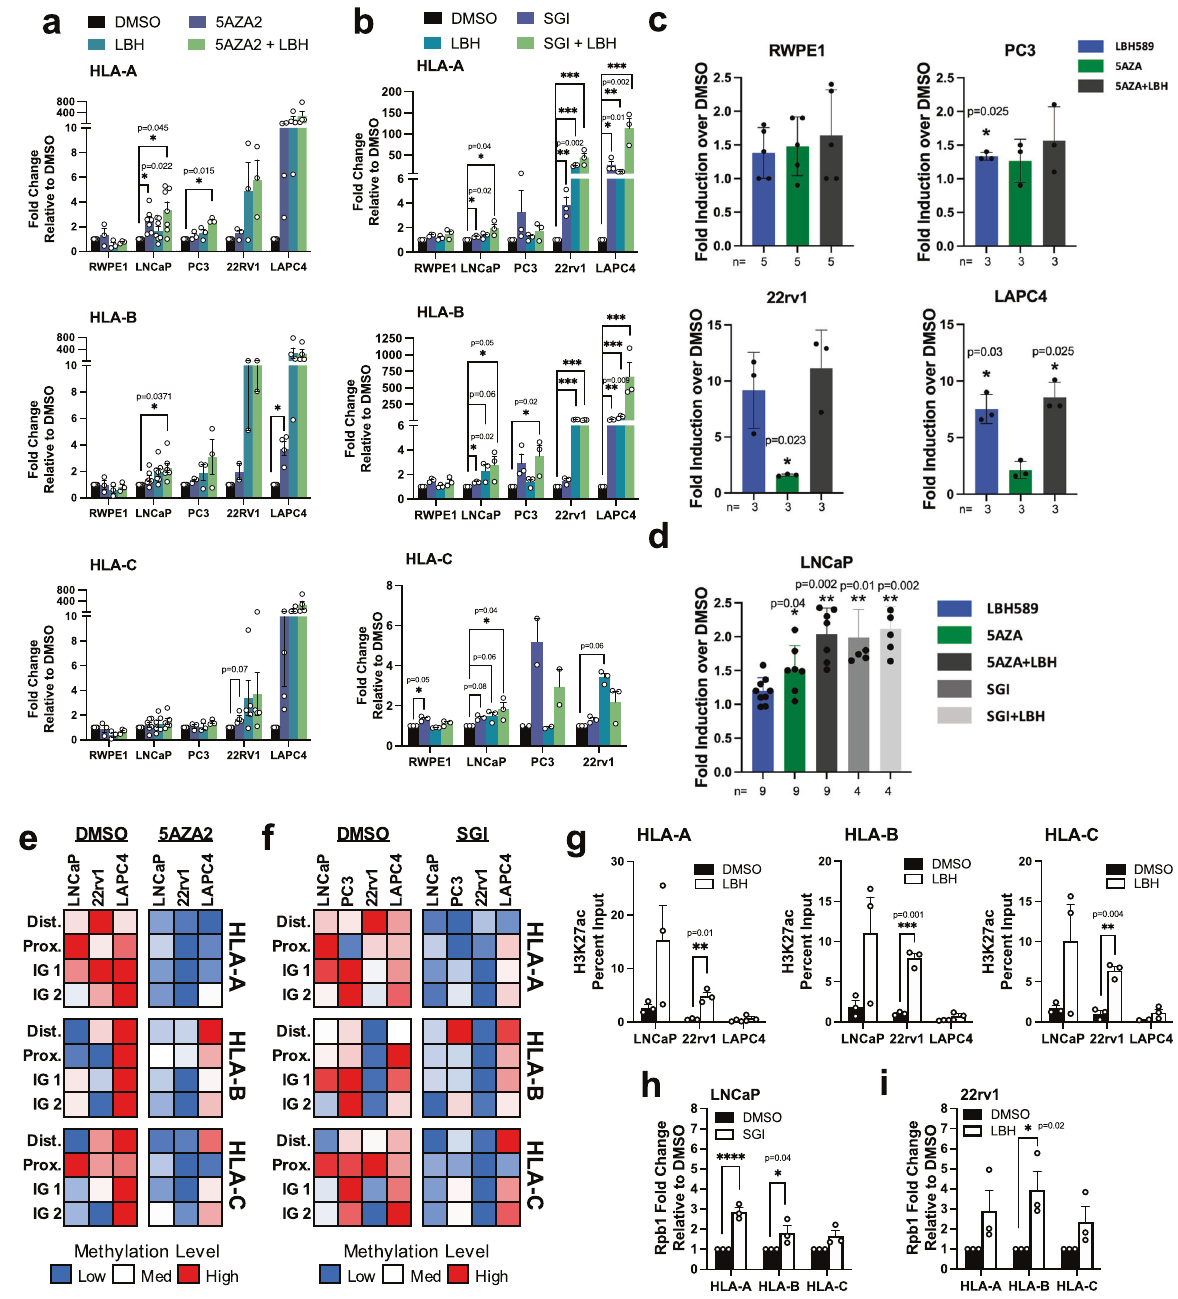
Fig. 4 Pharmacological inhibition of DNMTs and HDACs induces HLA-I gene and protein expression. Gene expression changes in HLA-A, HLA-B, and HLA-C in response to a 5AZA2 and LBH, with error bars representing SEM; n = 3 RWPE1, PC3, 22rv1 HLA-A; n = 4 LAPC4; LNCaP n = 5 HLA-A; n = 7 HLA-B, n = 6 HLA-C; n = 2 22rv1 HLA-B; n = 5 22rv1 HLA-C, except 5AZA2 n = 4 or b SGI and LBH alone and in combination. Data is from 3 independent experiments and shown as fold change relative to DMSO-treated cells. LAPC4 was excluded for HLA-C fold change analysis because HLA-C was undetectable in DMSO-treated LAPC4 cells. Error bars represent SEM. c Induction of HLA-I protein expression on the cell surface in indicated cell lines in response to 5AZA2 and LBH treatment alone and in combination. d Induction of HLA-I protein expression on the cell surface of LNCaP cells in response to 5AZA2, SGI, or LBH alone and in combination. Flow cytometry data in ( c ) and ( d ) is expressed as fold-over induction of Median Fluorescent Intensity normalized to DMSO-treated cells from at least three independent experiments. Mean + / − SD. e Heat map showing methylation levels in DMSO or 5AZA2 treated cells in four regions of the HLA-I genes from three independent experiments. f Heat map showing methylation levels in DMSO or SGI treated cells in four regions of the HLA-I genes from two independent experiments. g ChIP using antibodies to H3K27ac and H3K27me3 in LNCaP, 22rv1, and LACP4 cells treated with DMSO or LBH. h ChIP using an antibody to RPB1 in LNCaP cells treated with DMSO or SGI. i ChIP using an antibody to RPB1 in 22rv1 cells treated with DMSO or LBH. All ChIP data is representative of three independent experiments. For heat maps: Each heat map row was generated independent of other rows. Comparisons can be made between cell lines and treatment groups for each gene region individually, but not between different gene